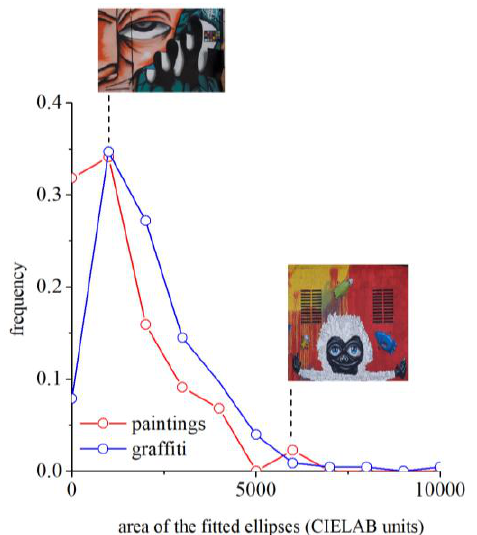
Figure 6. Distribution of the areas of gamuts of the 228 graffiti and 44 paintings expressed in CIELAB units. These areas are a measure of the number of colors that can be seen in each graffiti or painting. As illustration, two examples are shown for the graffiti: one with small area showing a reduced number of colors and one with a large area showing a considerable diversity of colors. The average areas are 6.2 × 10 3 for graffiti and 3.4 × 10 3 for paintings. These calculations apply for viewing distance close to the resolution of the human eye, e.g., of about 1.5 m for the graffiti and about 1.8 m for paintings. Graffiti represent more colors than paintings, which translate in the perception of greater chromatic richness.